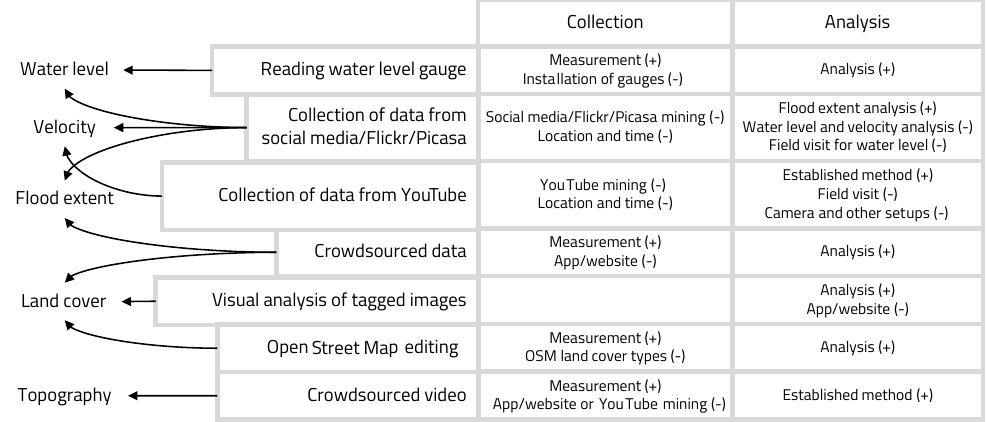
Figure 6. Pros and cons of collection and analysis methods used to collect flood-related data by citizens.